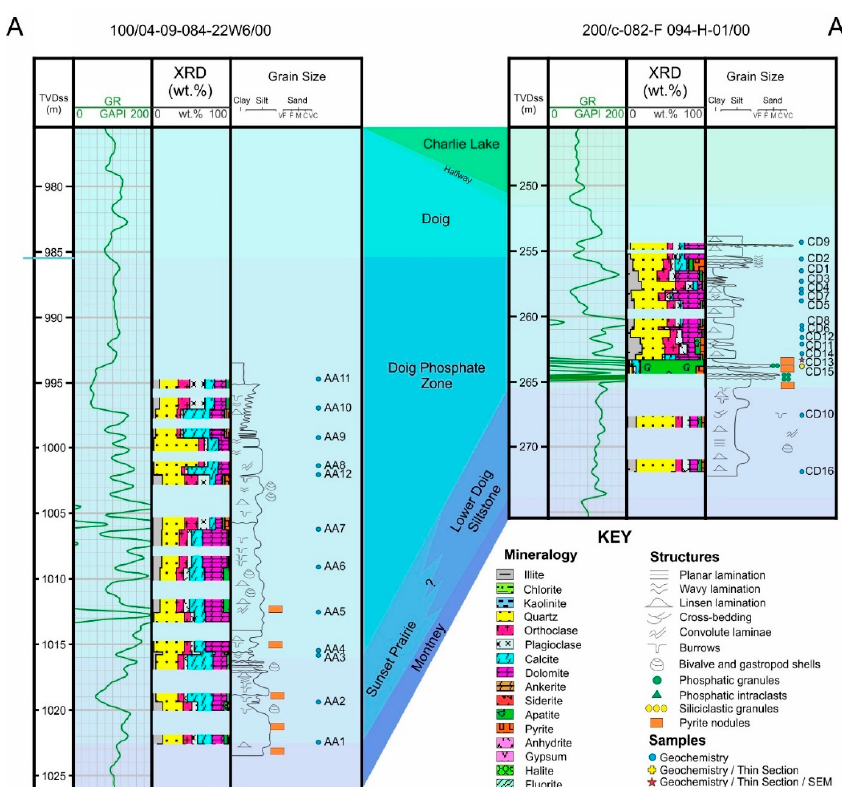
Figure 3. Stratigraphic dip cross-section of wells analyzed and described in this study, with gamma-ray log, core log, and sample locations. The location of the cross-section is shown in Figure 1.